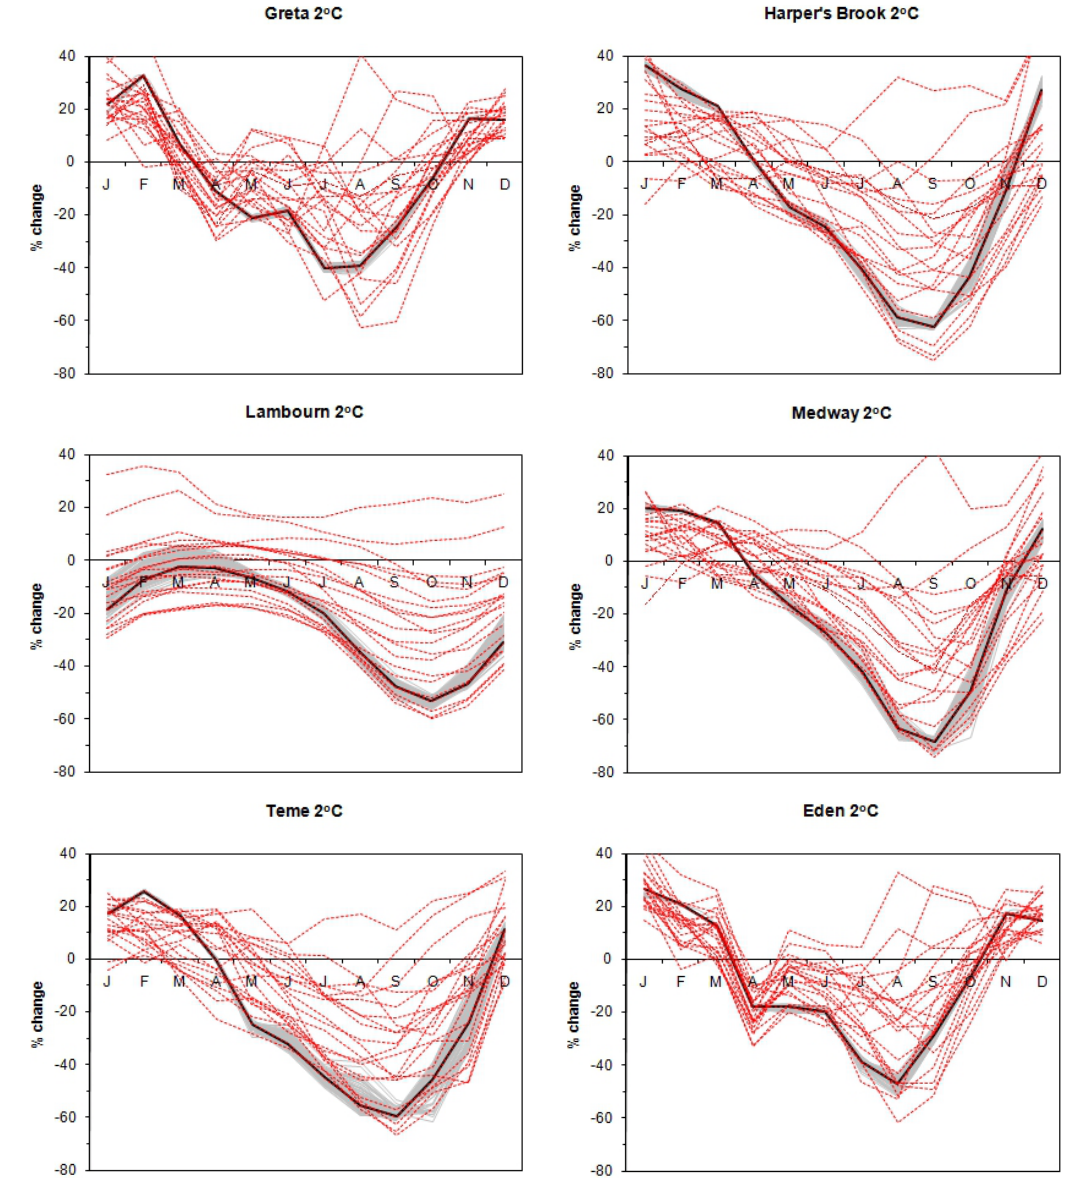
Fig. 8. Change in mean monthly runoff for the each catchment for a 2 ◦ C rise in global mean temperature, under the 21 climate scenarios and, for the HadCM3 pattern, 100 sets of catchment model